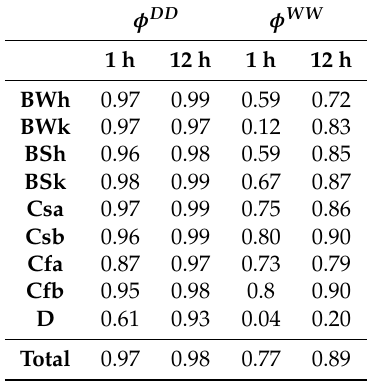
Figure 4. Performance evaluation of the random forests-based model (RFB) for the transition probabilities dry-dry and wet-wet for 1-h intervals. Results are shown in the same way as defined in Figure 3. Table 4. Coefficient of determination ( R 2 ) computed through 10-fold cross-validation for the 1-h and 12-h variance for the random forests-based model (RFB) proposed in the present